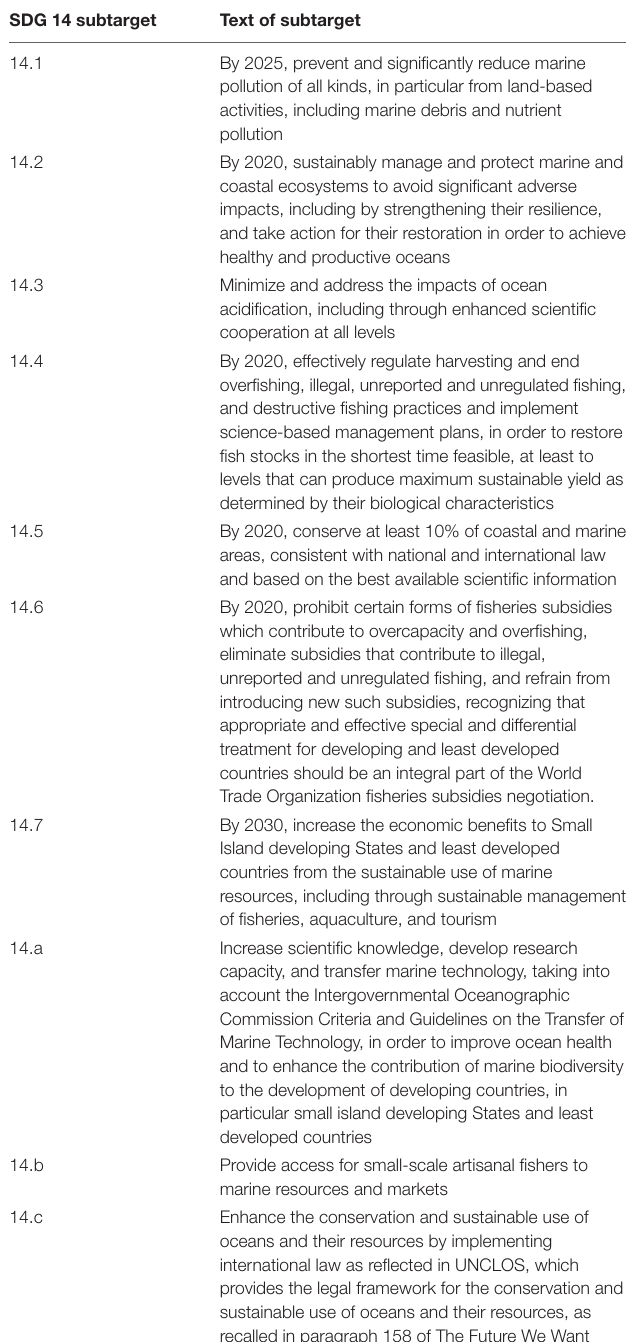
TABLE 1 | SDG 14 subtargets and what thematic area they